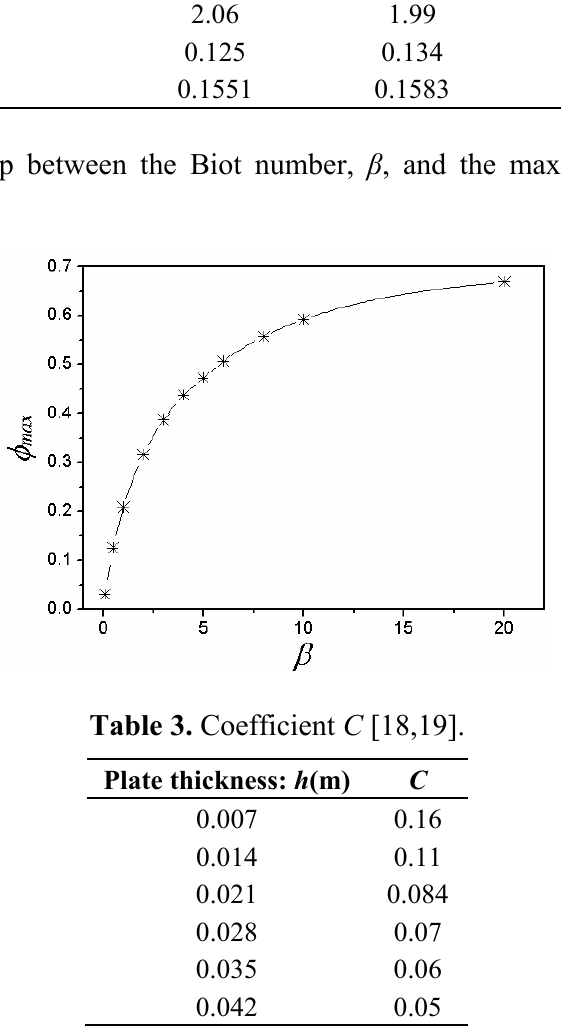
Table 2. The related material parameters of HfB T (avg), respectively (the cooling rate is assumed to be 200 °C·s −1 , and the initial temperature is 1,300 °C).